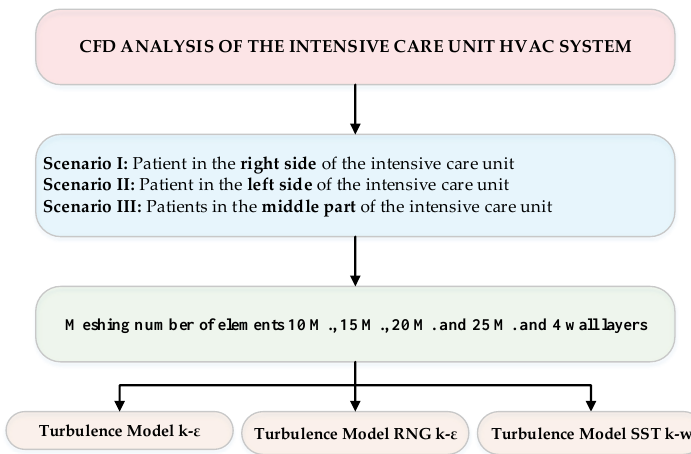
Figure 5. CFD analysis scheme for the cardiac intensive care unit simulations.